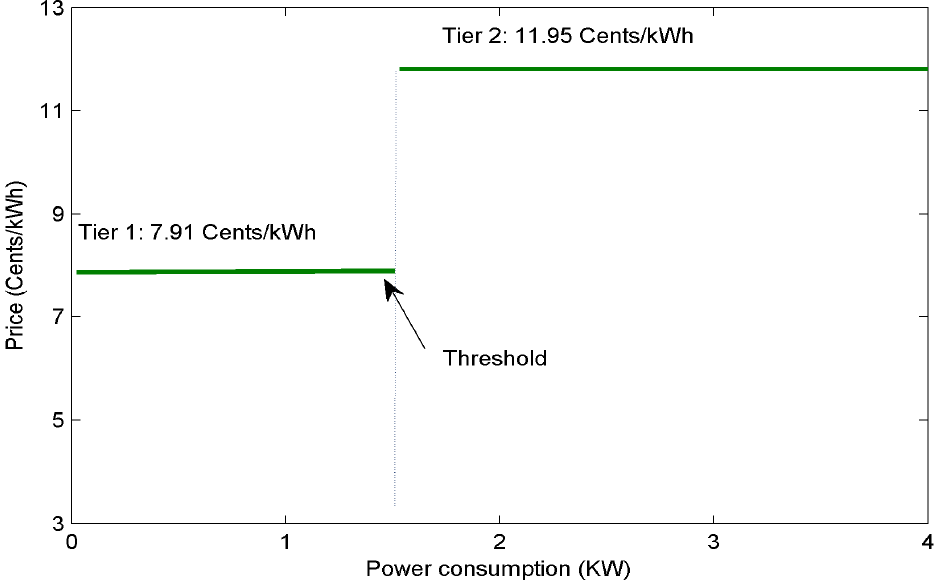
Figure 5. Example of 2TP model used by the British Columbia Hydro Residential usage charge updated in 1st April 2015 [29].